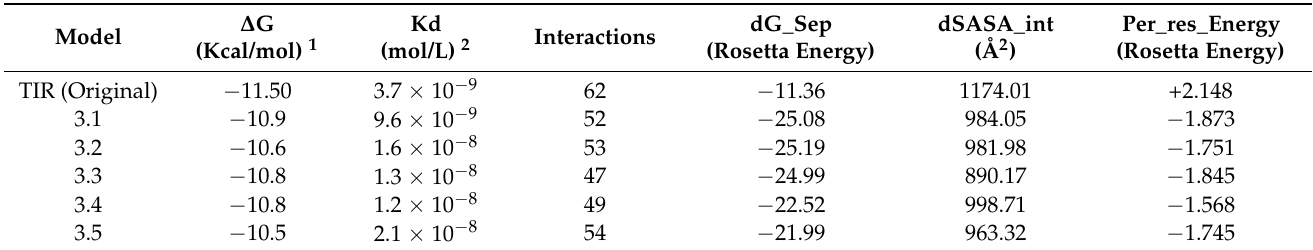
Table 2. Interaction parameters between peptide models and the Intimin protein obtained with the FlexPepDock and Prodigy Haddock